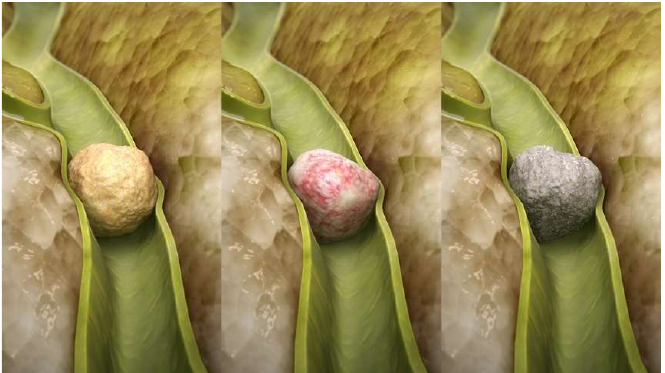
Figure 2. Gallbladder gallstones (calculi). A visual design illustrating the three types of gallstones